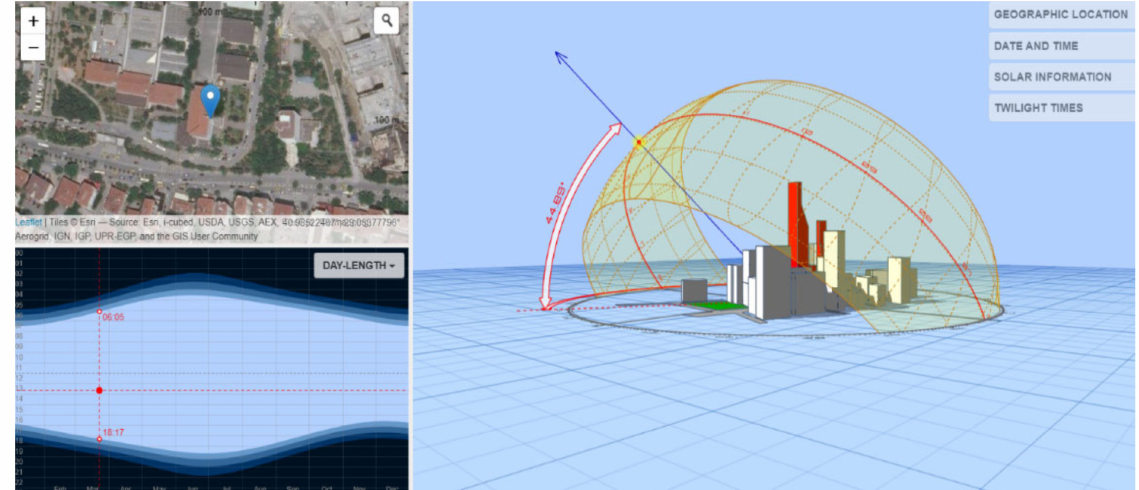
Figure 6. Geographic location of the faculty building and solar positions.